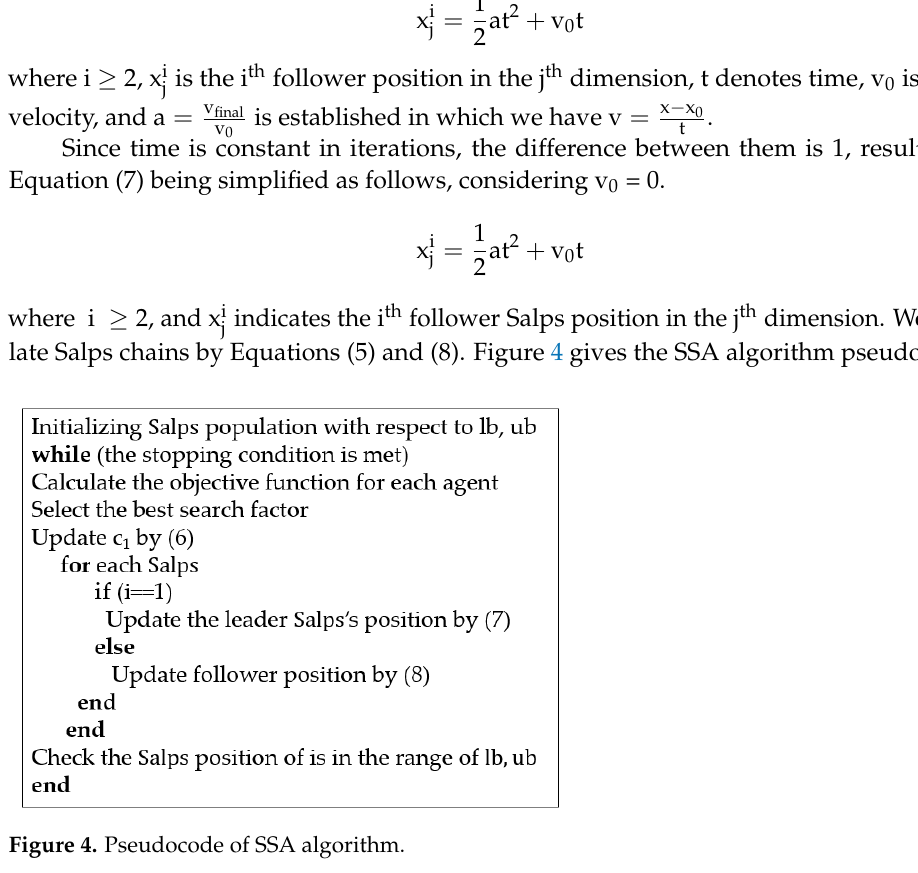
Figure 4. Pseudocode of SSA algorithm.